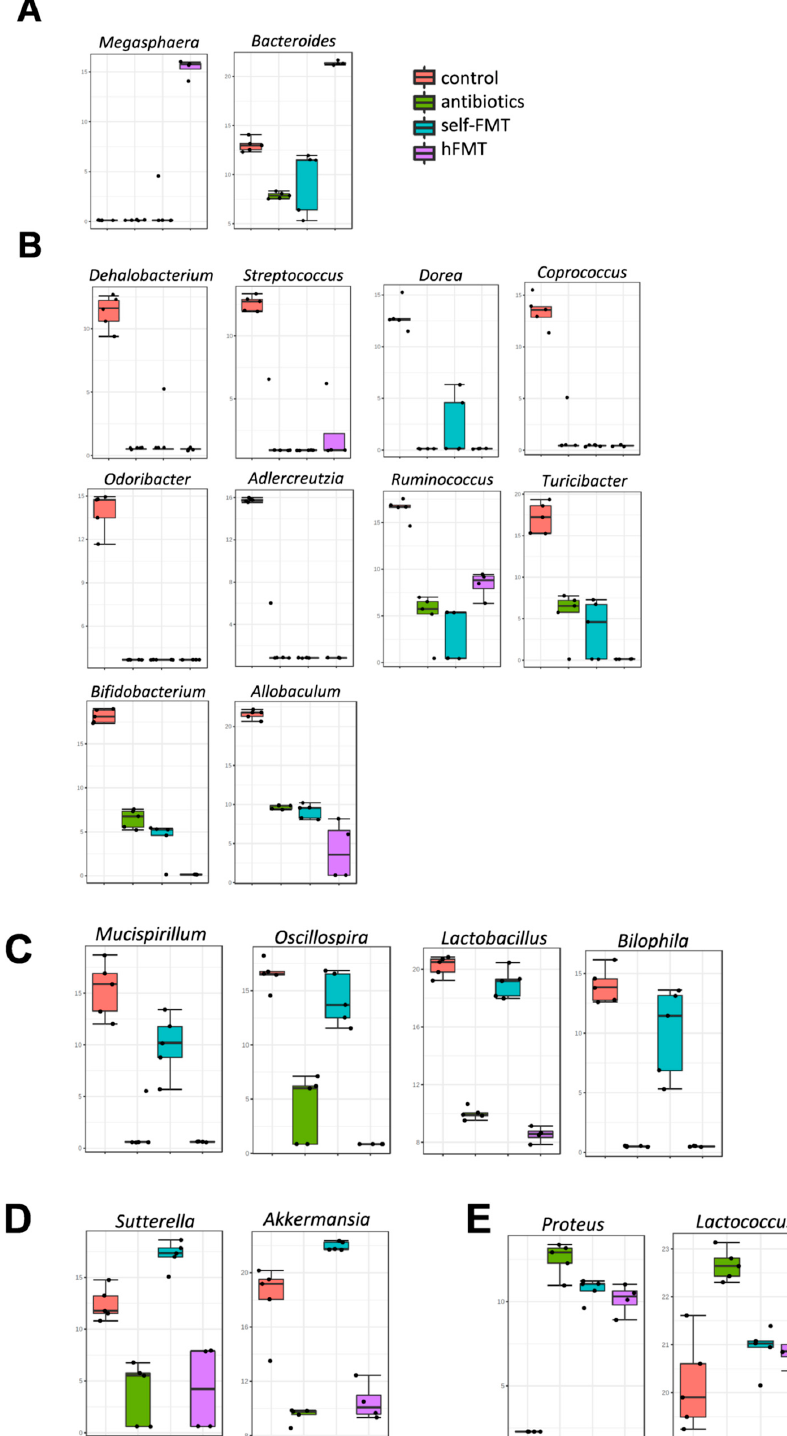
Figure 4. Relative abundances of bacterial taxa (family and genus) in donor feces and feces of mice subject to hFMT. The panel ( A ) shows the relative abundance of bacteria at family level of the donor sample while panel ( B ) shows the same at genus level.